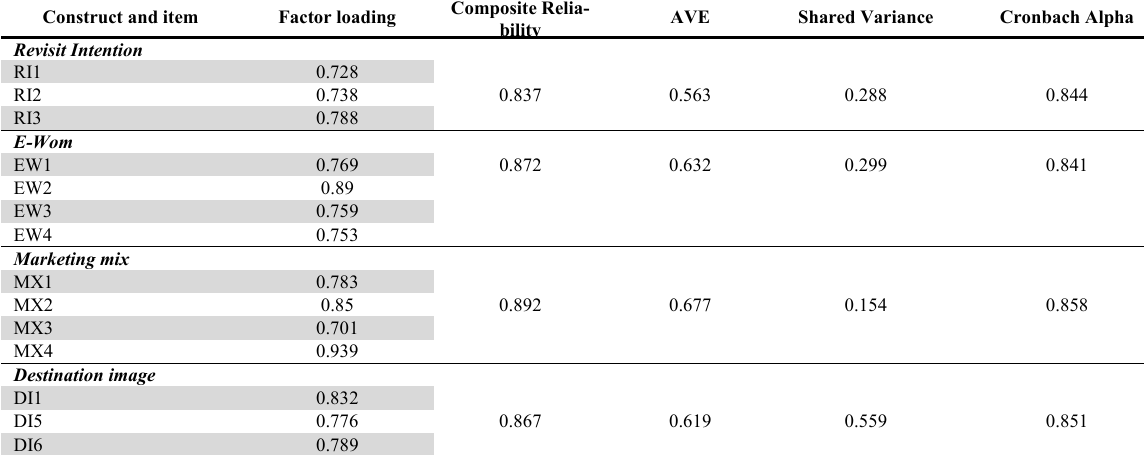
Table 1 Reliability, Convergent and Discriminant Validity Result Summary Construct and item